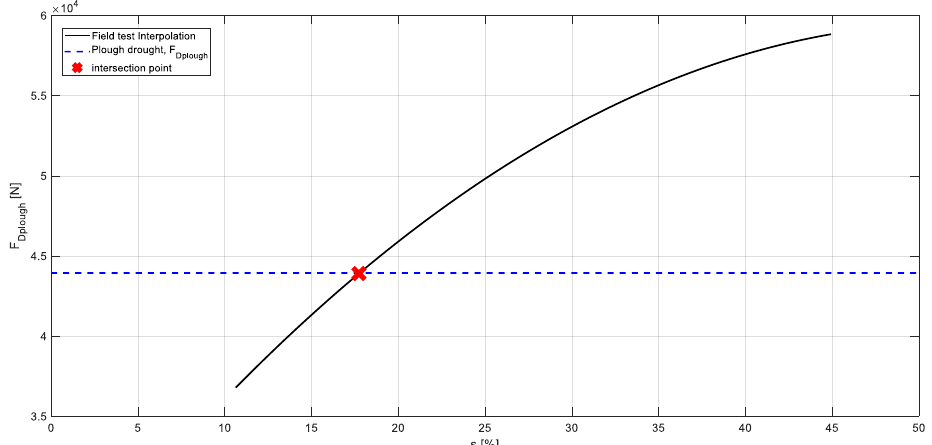
Table 6. Regression curves for F Dplough as a function of s (TT in 8th gear).